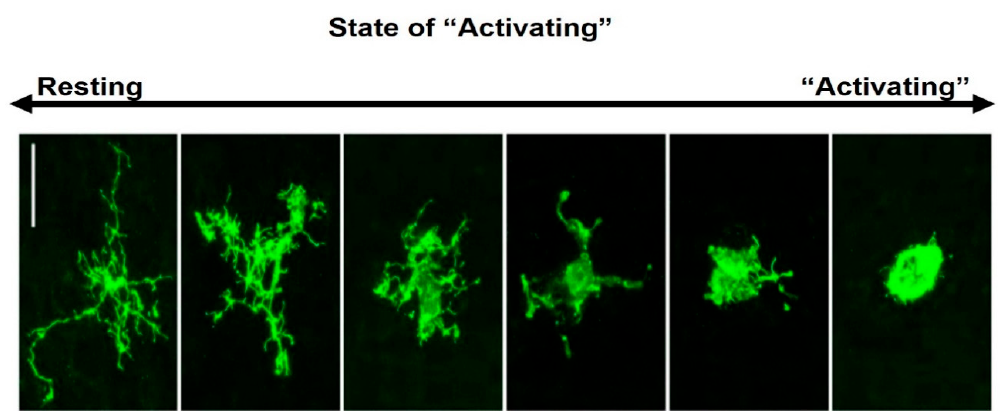
Figure 1. Morphological features of ramified and amoeboid microglia. The resting-state shows a small soma and fine ramified processes (may be referred to as M0, unactivated or homeostatic). Following ischaemia, microglia display changes in morphology, retracting their processes and developing a large (amoeboid) soma. These morphologies are illustrated for Iba1+ microglia in macaque neocortex